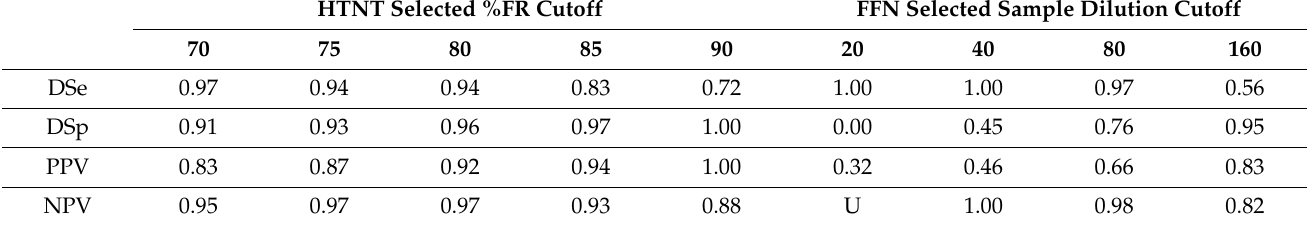
Table 1. Diagnostic sensitivity (DSe), Diagnostic specificity (DSp), Positive Predictive Value (PPV) and Negative Predictive Value (NPV) for HTNT and FFN assays using various cutoffs listed in the second row of the table. For example, for the HTNT assay at a cutoff of 70, the DSe = 0.97 (97%), the DSp = 0.91 (91%), PPV = 0.83 (83%) and NPV = 0.95 (95%). U = undefined. HTNT Selected %FR Cutoff FFN Selected Sample Dilution